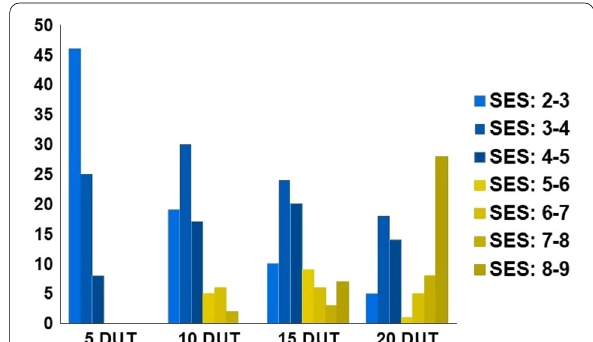
Fig. 1 Changes in SES score distributions among 97 accessions from 5 to 20 days under treatment (DUT) with 100 mM NaCl. The responses of the 97 rice accessions to 100 mM NaCl treatment were assessed with three replications, evaluated by the SES score, and recorded at 5, 10, 15, and 20 DUT. As indicated in Additional file 2: Table S2, SES scores were grouped into seven classes: 2–3, 3–4, 4–5, 5–6, 6–7, 7–8, and 8–9, as indicated by different colors. SES scores of 2–5 defined salinity-tolerant accessions; SES score above 5 were considered salinity-sensitive